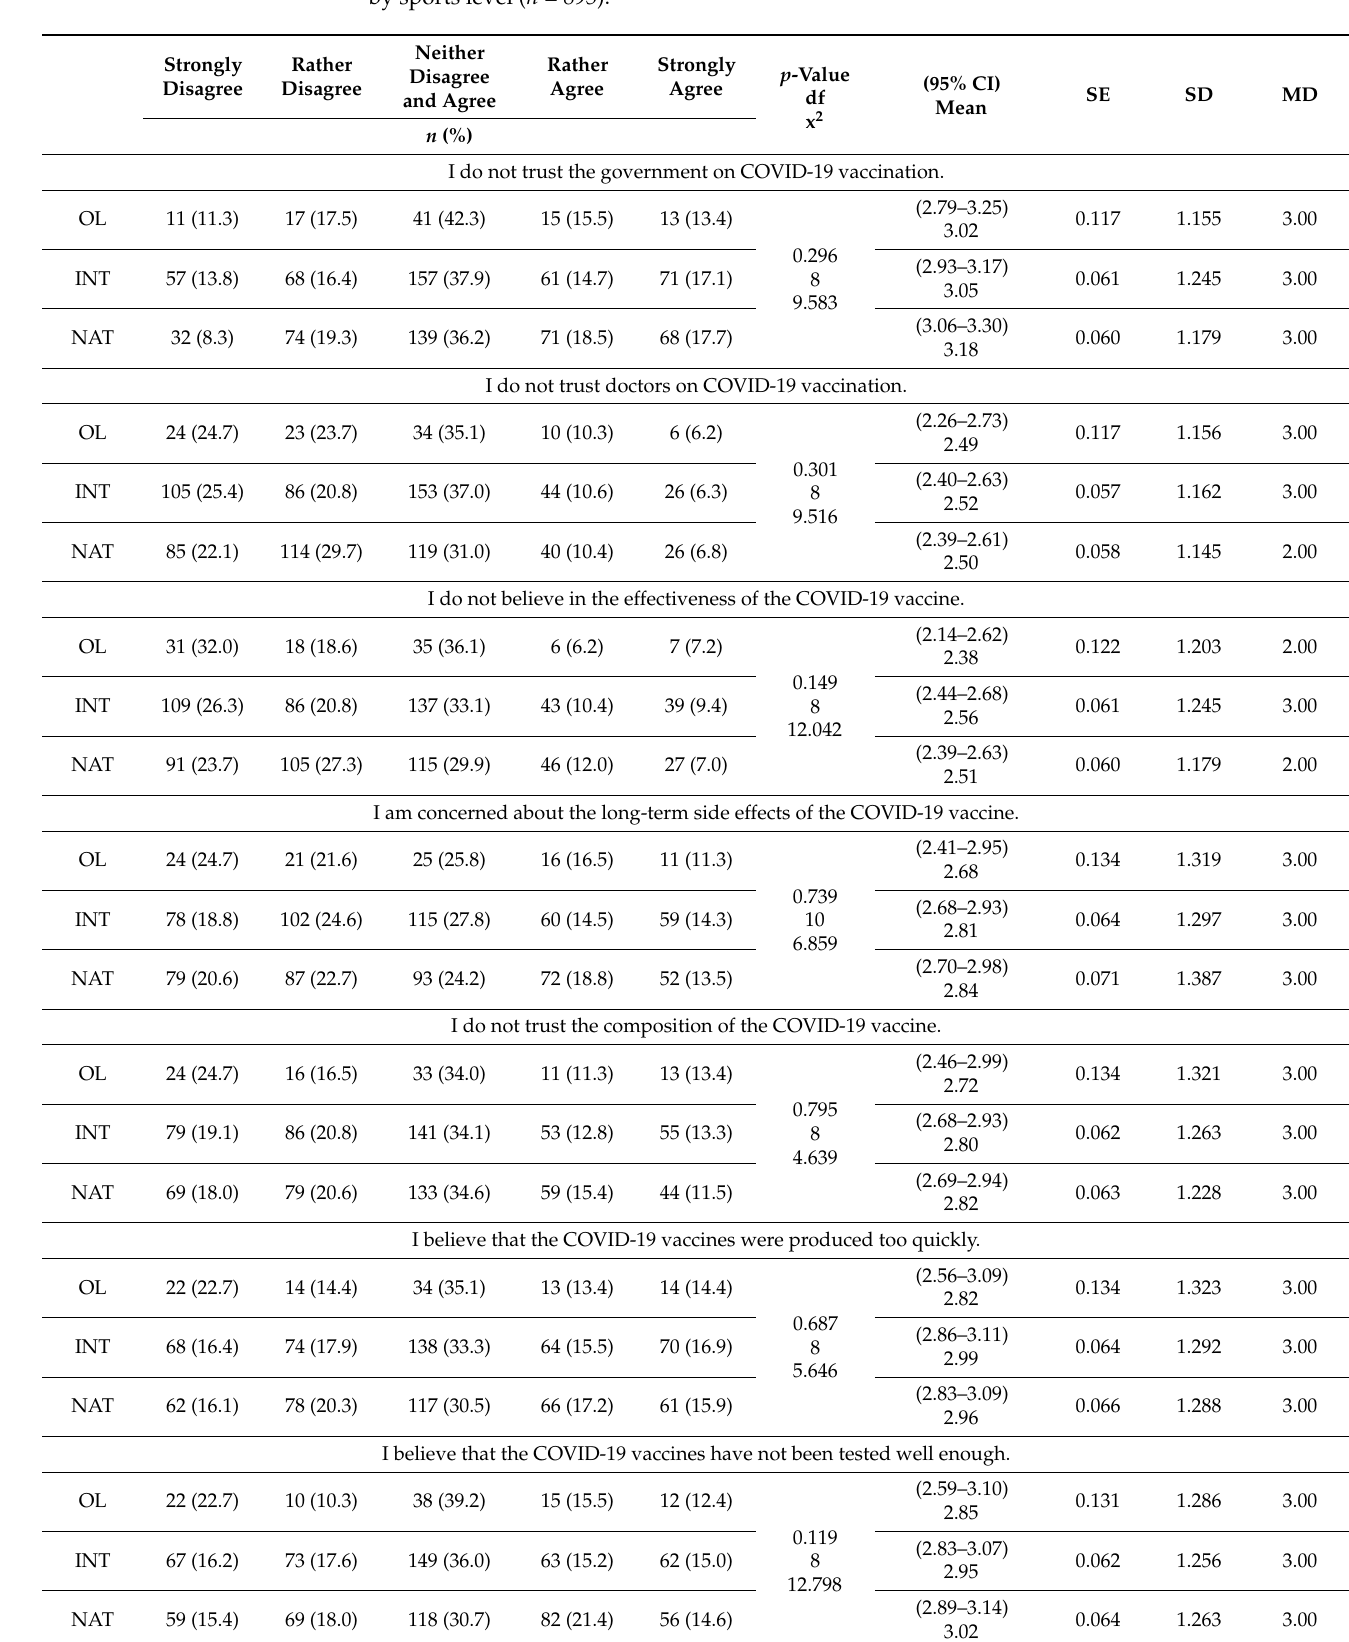
Table 11. Athletes’ concerns and beliefs related to COVID-19 vaccination and COVID-19 pandemic by sports level ( n =